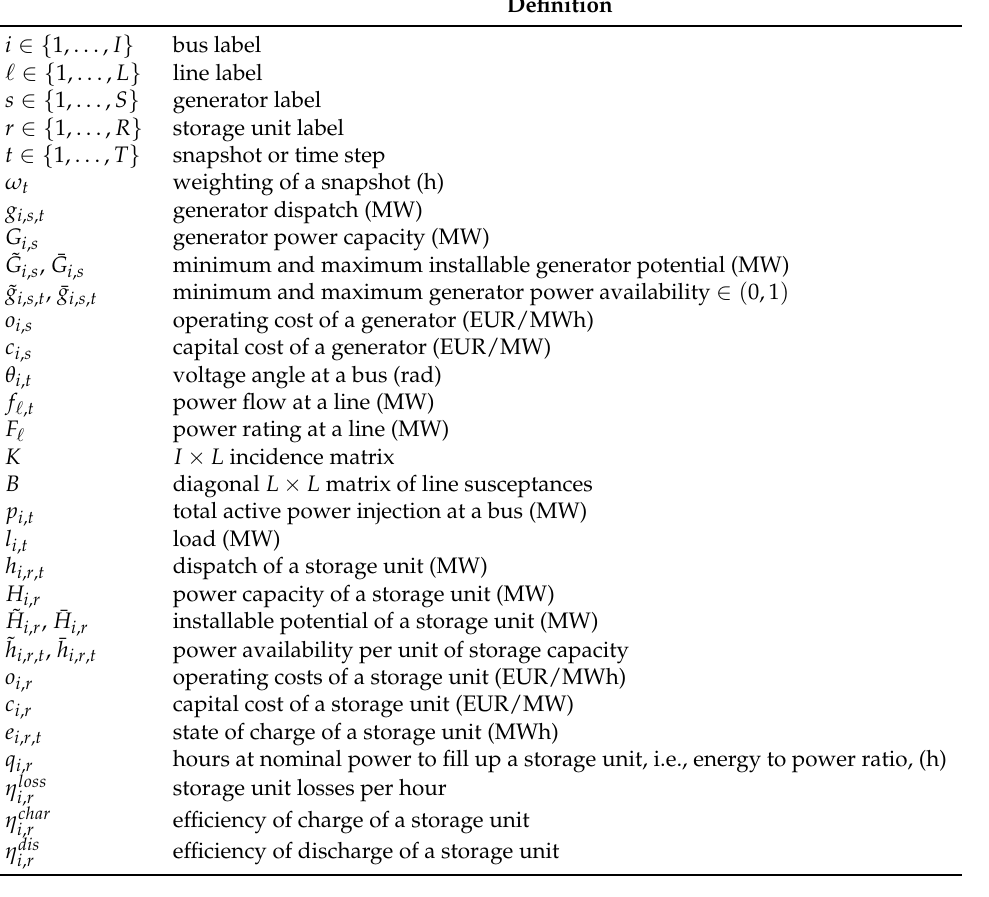
Table 3. Variables, coefficients and indices of the Angles+Flow multi-period with long term storage formulation of the